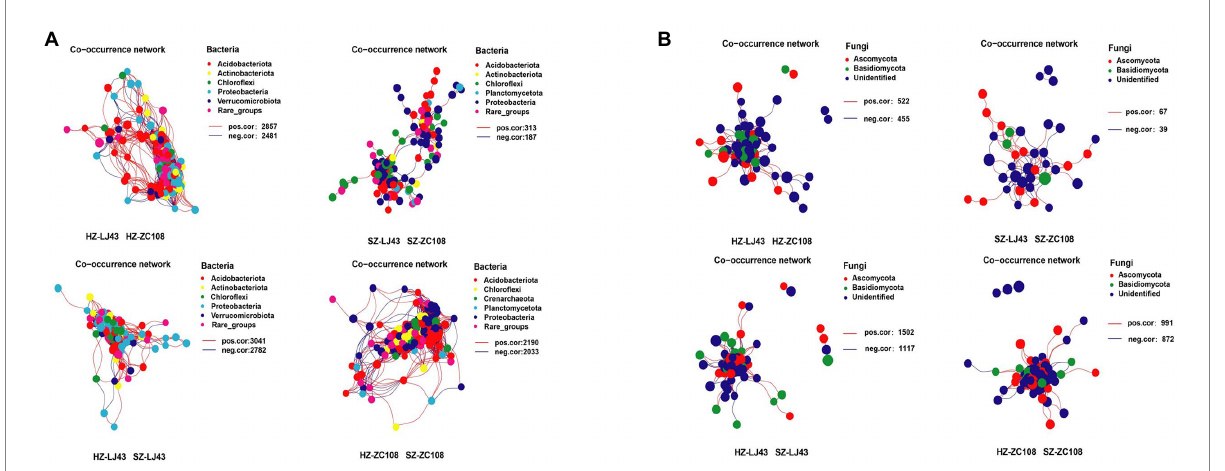
FIGURE 2 (A) The bacterial co-occurrence networks based on OTU correlation analysis. The OTU with a relative abundance above 0.1% was selected. A connection stand for a strong (Pearson’s r > 0.7) and significant ( p < 0.01) correlation. The size of each node is proportional to the relative abundance of each OTU. The red edge represents a positive correlation, and the blue edge represents a negative correlation. (B) The fungal co-occurrence networks based on OTU correlation analysis, and the analysis method is the same as (A)